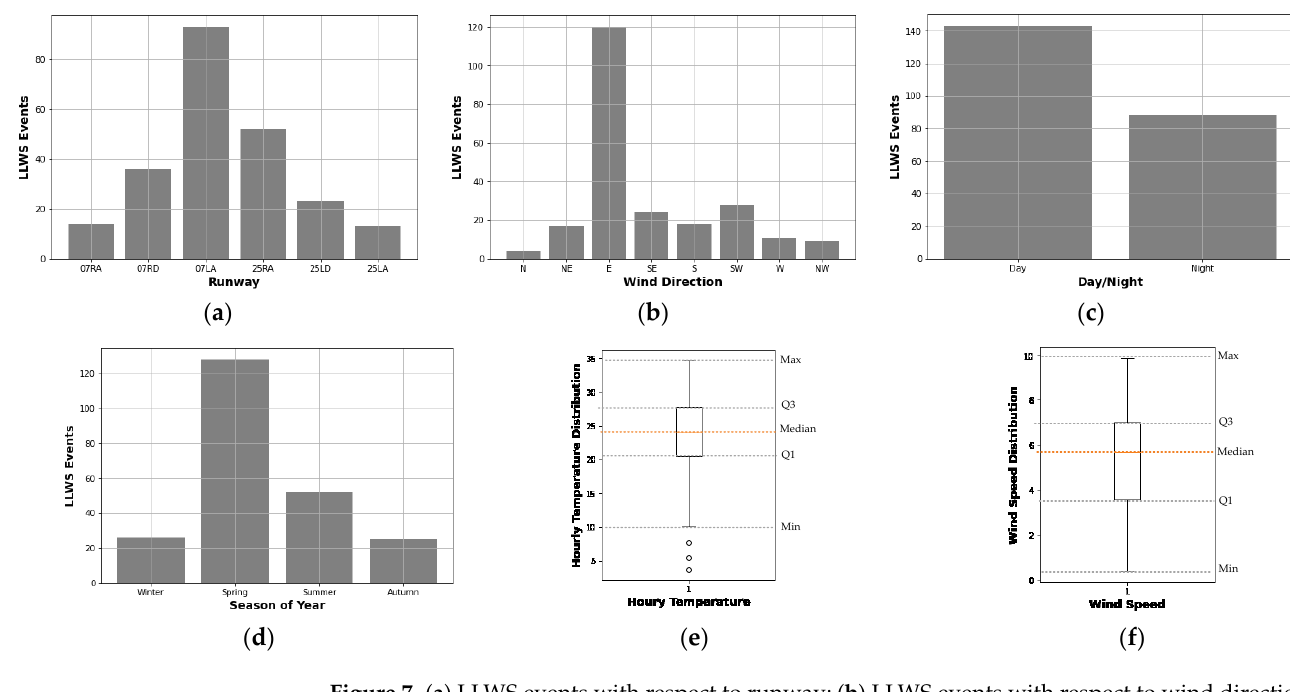
Figure 7. ( a ) LLWS events with respect to runway; ( b ) LLWS events with respect to wind direction; ( c ) LLWS events with respect to day/night; ( d ) LLWS events with respect to season of year; ( e ) box plot of hourly temperature; ( f ) box plot of wind speed.